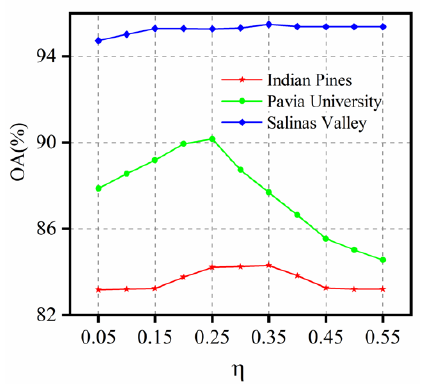
Figure 17. The influence of the parameter η on the OAs of classification